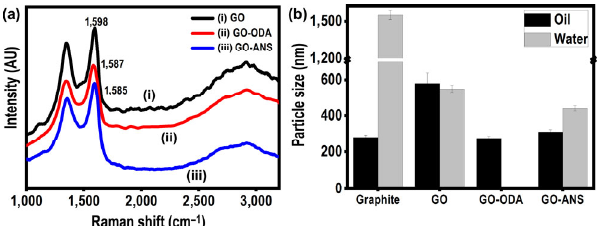
Fig. 2 (a) Raman spectra of GO, GO-ODA and GO-ANS. (b) Particle size measurements of graphite, GO, GO-ODA and GO- ANS in the oil/water suspension mixed using an ultrasonic